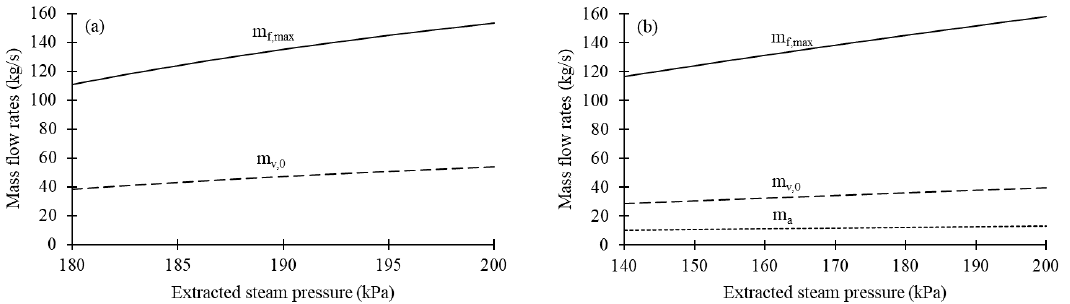
Figure 6. Variations of steam and juice mass flow rates with extracted steam pressure for ( a ) the forward - feed multiple - effect evaporator and ( b ) the backward - feed multiple - effect evaporator that have optimum distributions of heating surface areas .